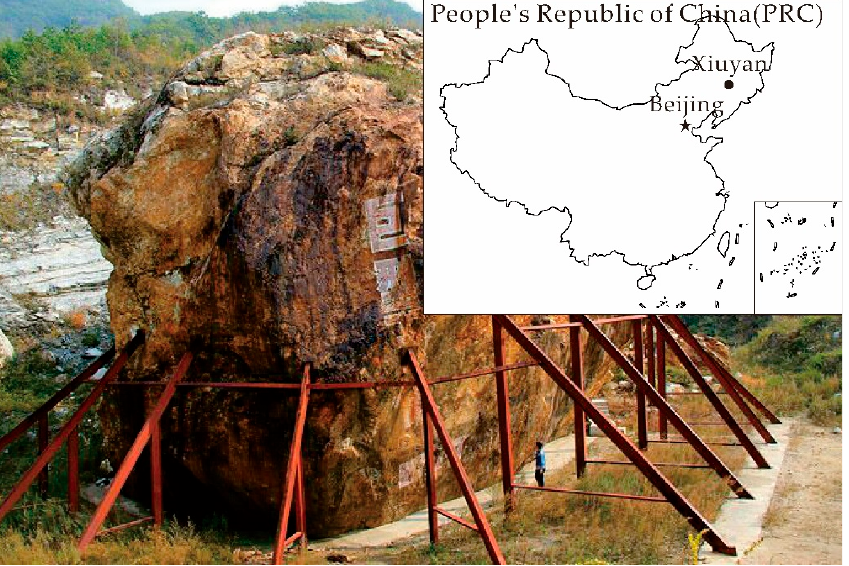
Figure 8. Field survey site and location map. The huge King Jade is located in the center of the photograph.